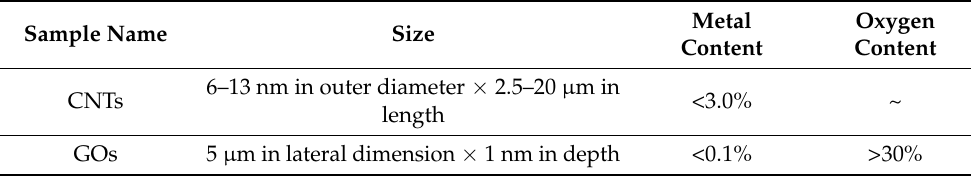
Table 1. Properties of CNTs and